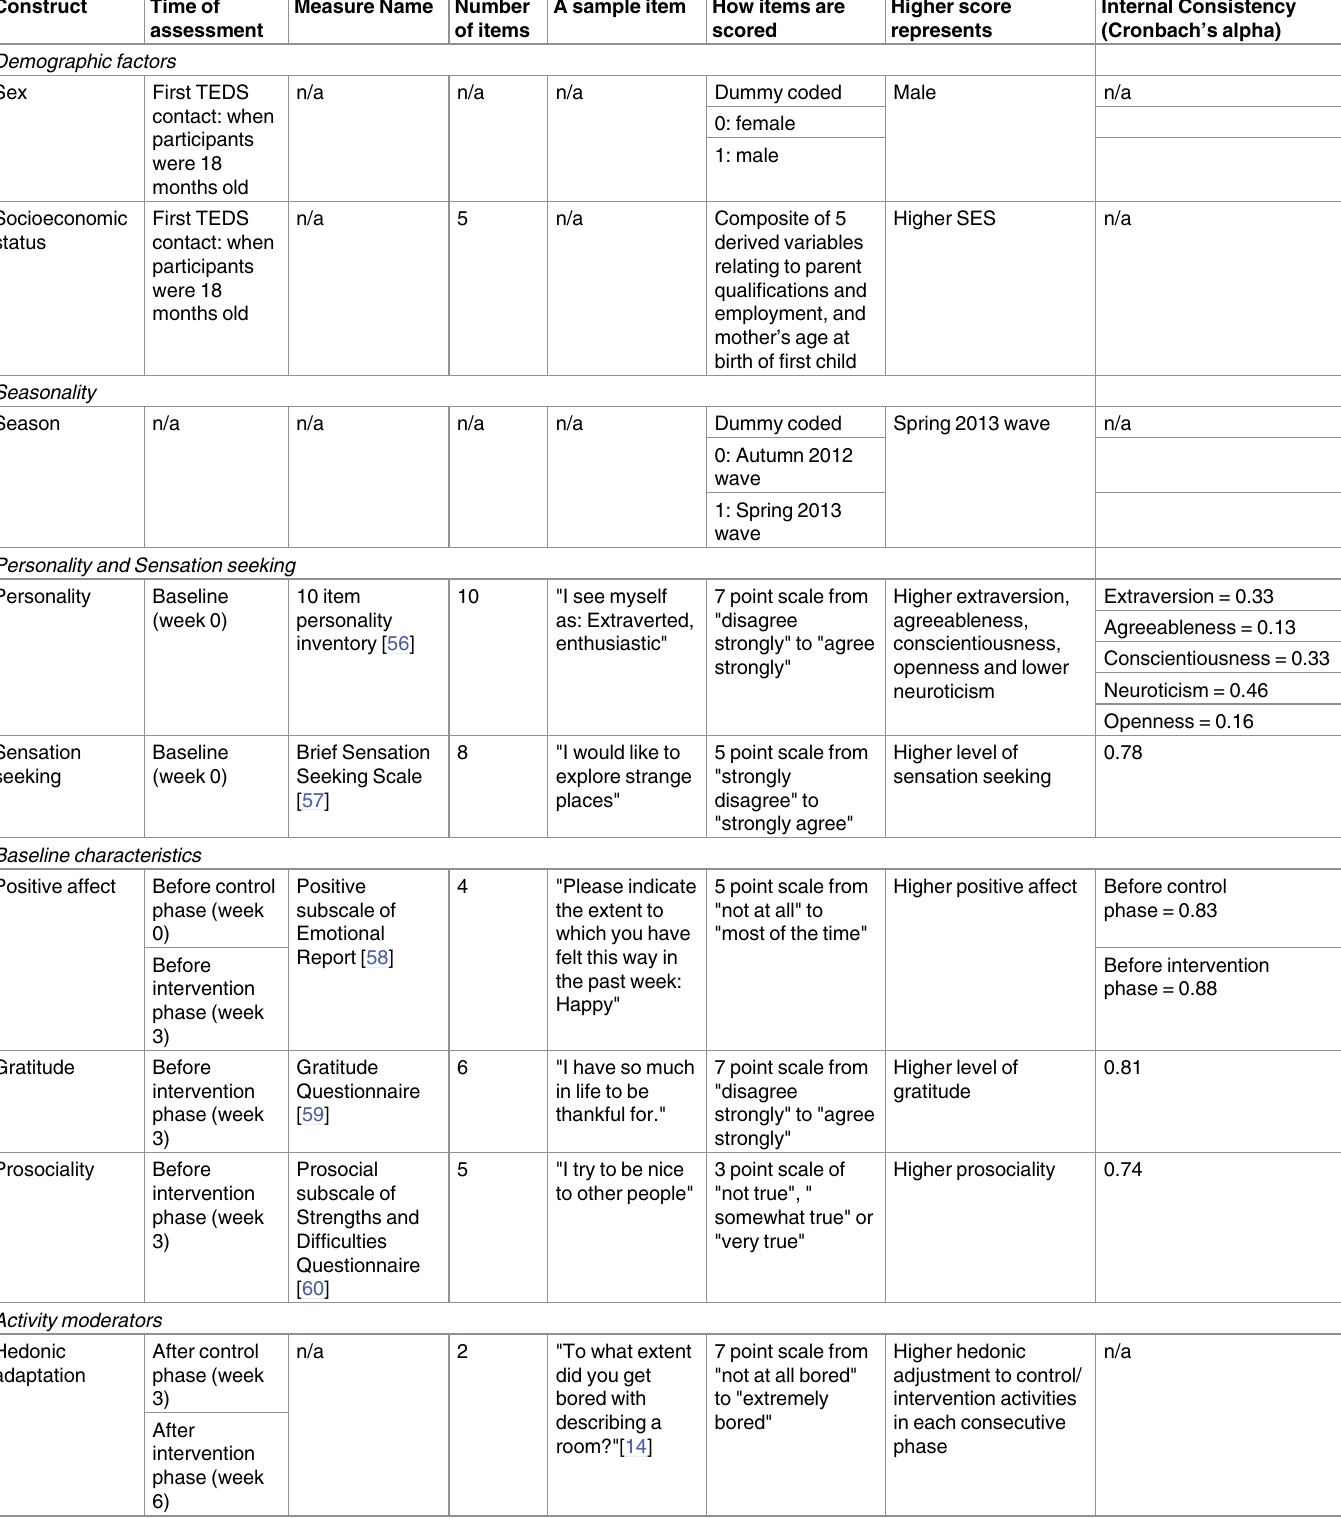
Table 1. Potential moderators of intervention